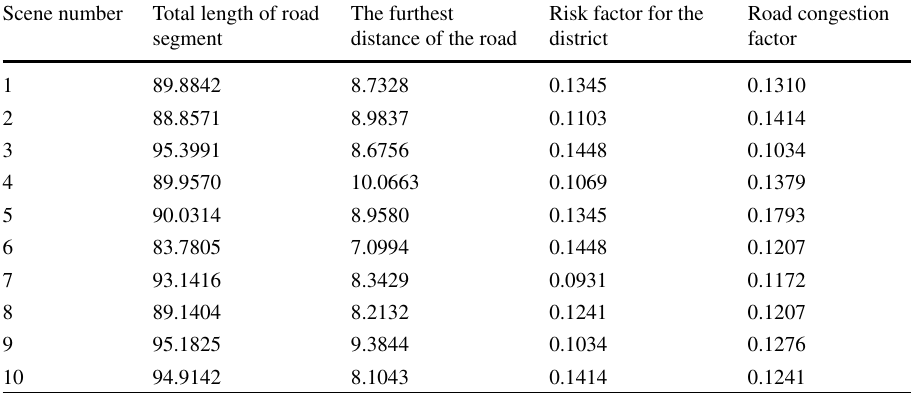
Table 3 Workload attributes of the small